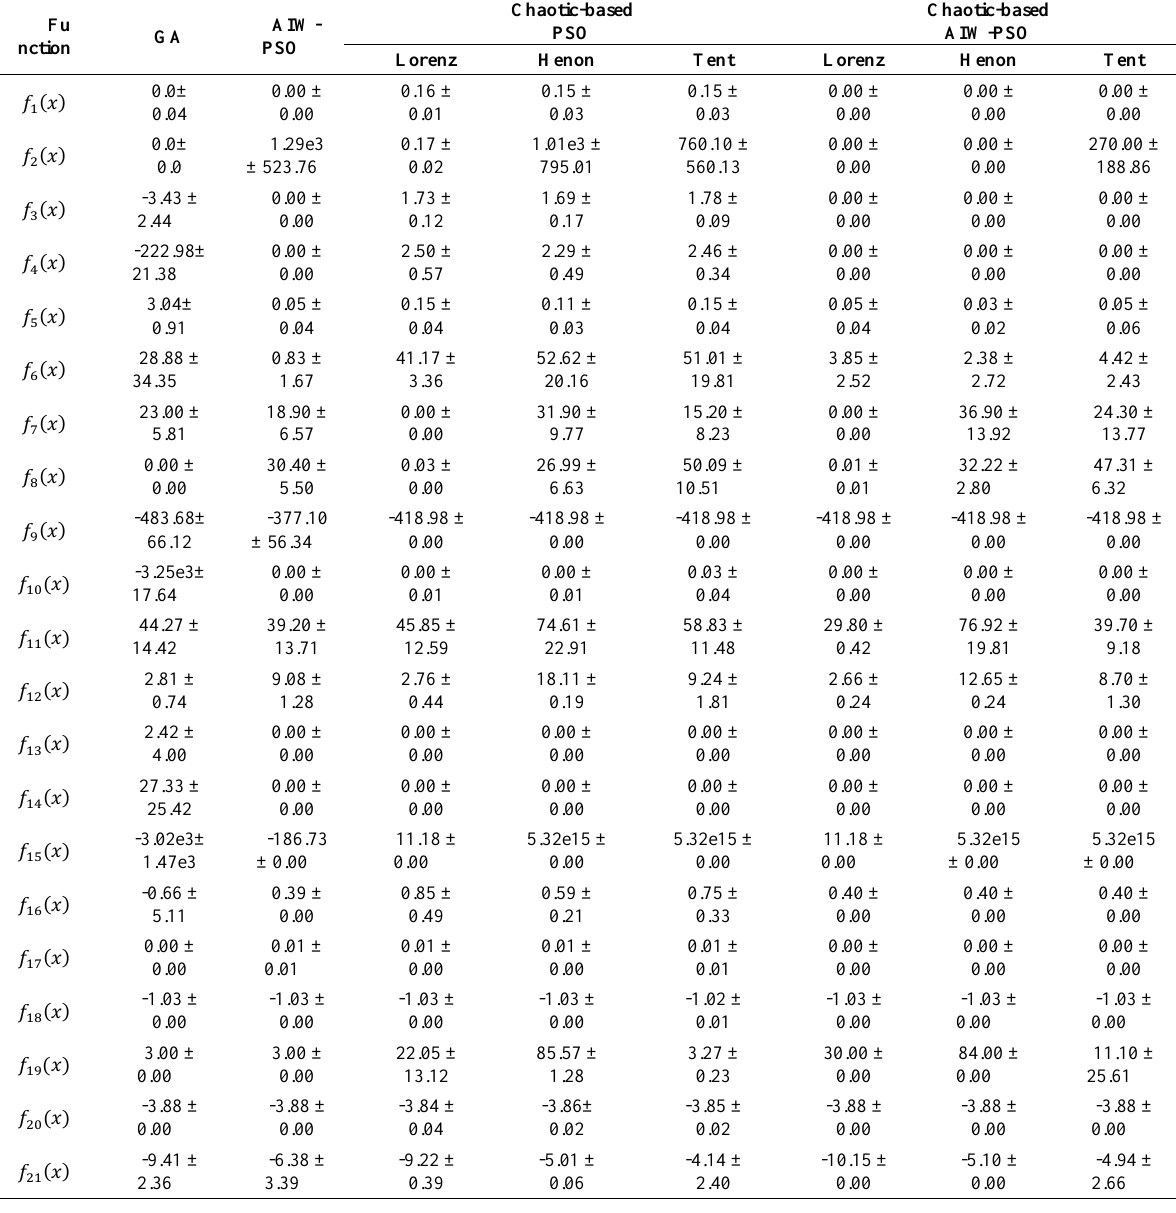
Table 5. The mean and Std of the best solution of the GA, AIW-PSO, chaotic-based PSO, and chaotic-based AIW-PSO methods over the complex functions.